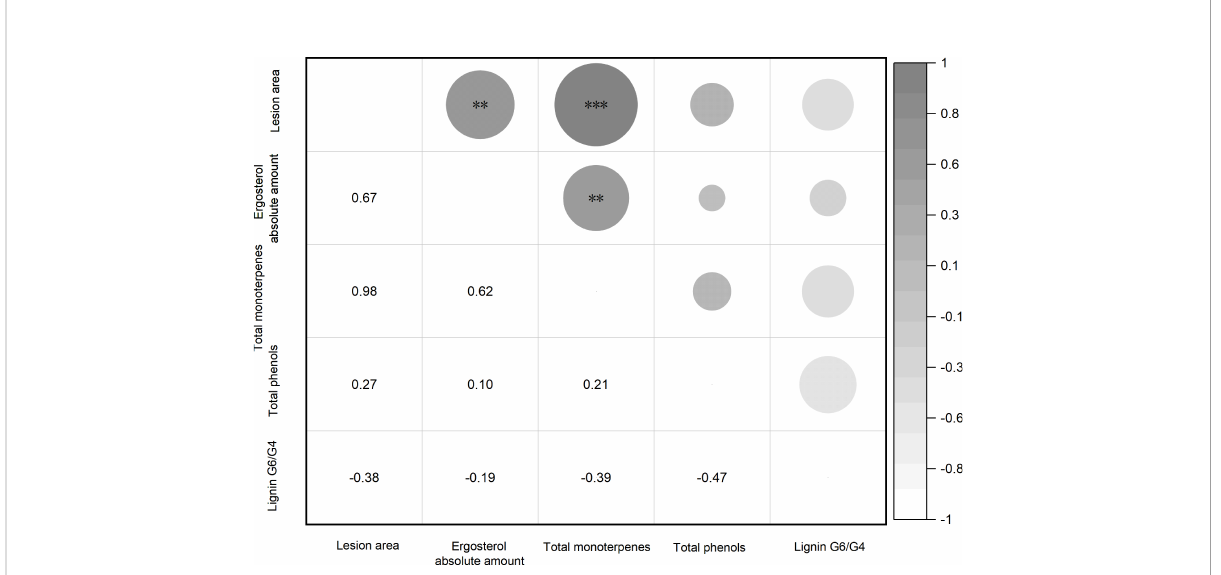
FIGURE 6 Correlation analysis for lesion area, ergosterol amount, total monoterpene, total phenols, and ratio of lignin G6 to G4 at 91 dpi. The number in the lower triangle represents the Pearson r value and the signi fi cant marker in the upper triangle represents the P range (** p < 0.01, *** p < 0.001; Pearson correlation, a =0.05; n =18 replicates per